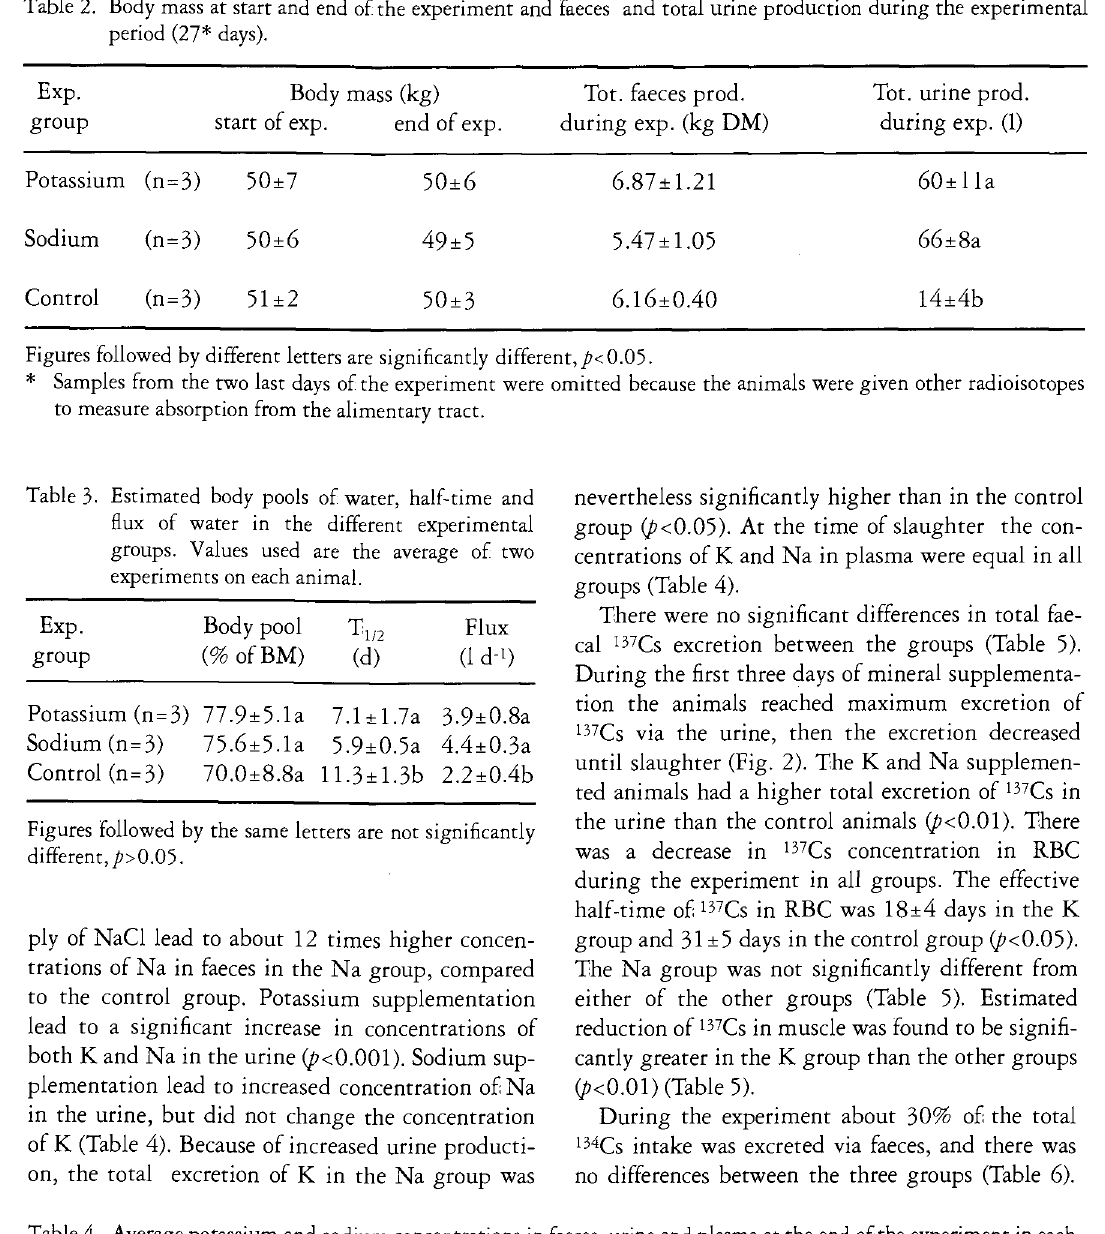
Table 4 . Average potassium and sodium concentrations in faeces, urine and plasma at the end of the experiment in each